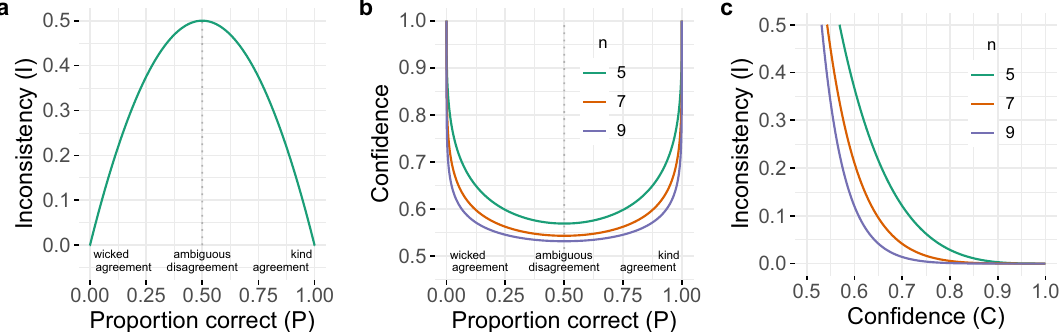
Figure 1. Predictions of the self-consistency model on the relations between the proportion of individuals who make a correct diagnosis ( P ), inconsistency ( I ; probability of making two inconsistent decisions), and confidence ( C ) for three values of n (number of sampled cues; color coded in (b,c) ). (a) Inconsistency as a function of the proportion of individuals making a correct decision. Note that this relationship does not covary with n (see Eq. (3)). (b) Confidence as a function of the proportion of individuals making a correct decision. (c) Inconsistency as a function of confidence. Note that the probability p with which a cue points to the correct option does not appear because, given any fixed number n of sampled cues, p and P are monotonically related (see Eq. (1)); thus the curves in (a,b) would not yield qualitatively different insights if p (instead of P ) were shown on the